Question: How would you classify this visualization?
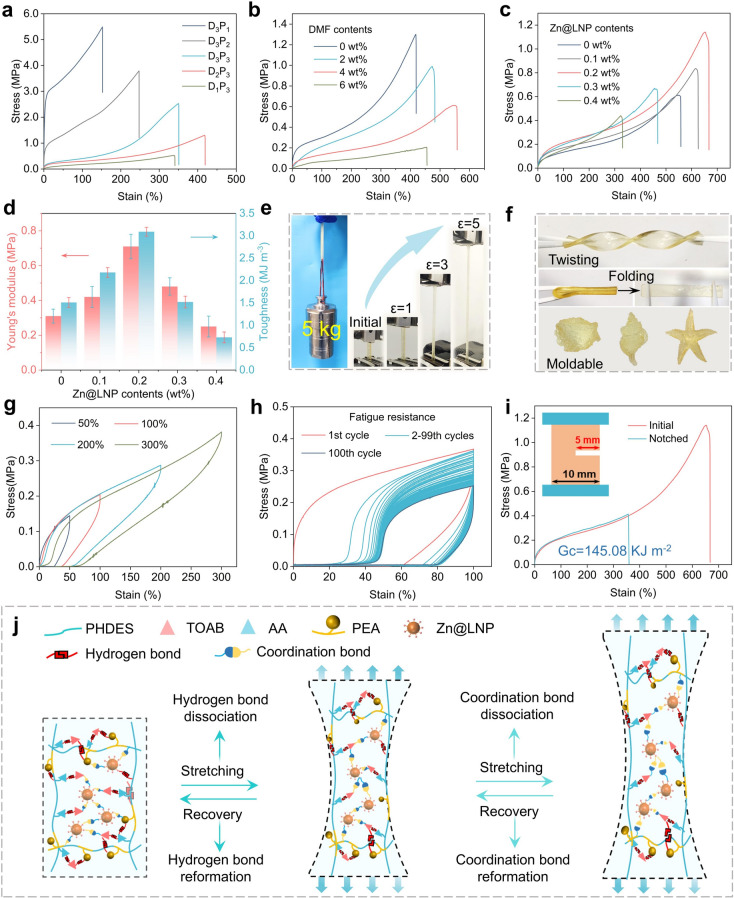
Answer: line